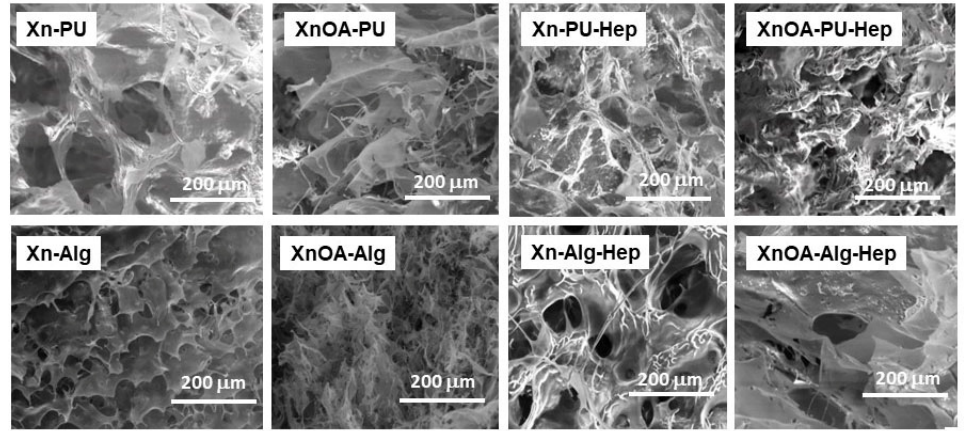
Figure 3. SEM micrographs of all materials.